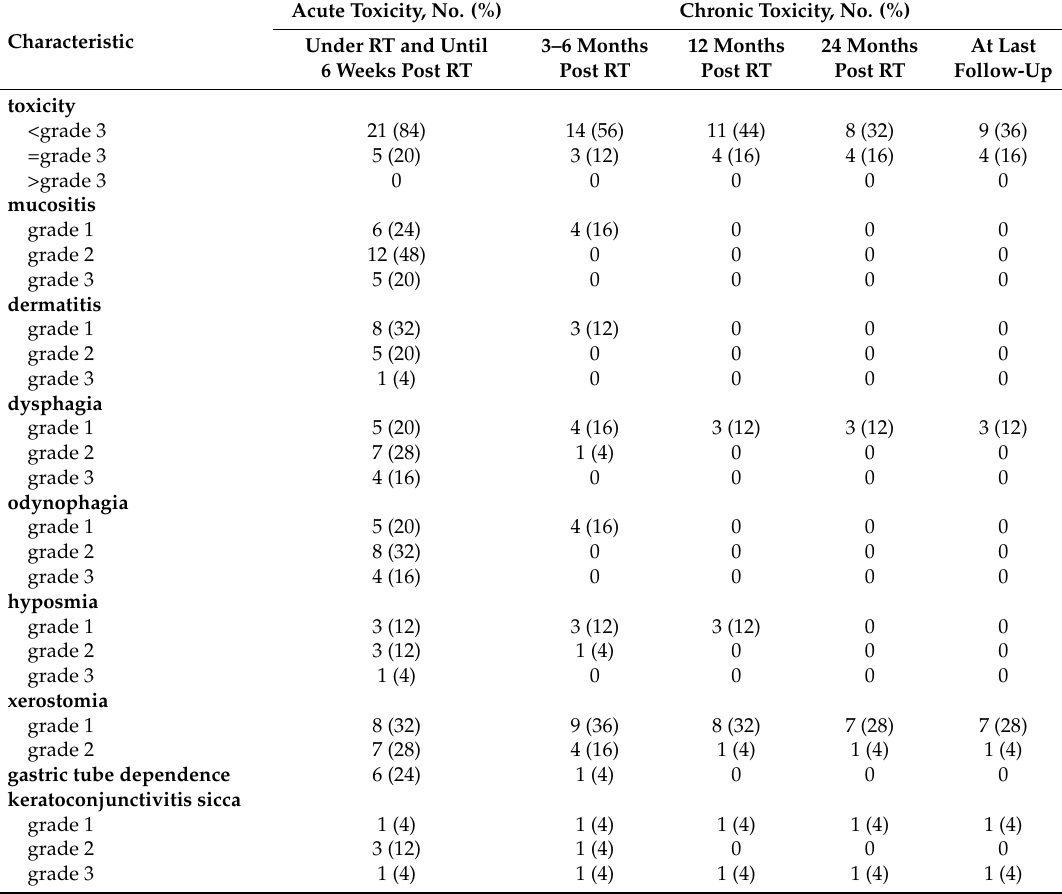
Table 2. Overview of acute and chronic toxicity, n =